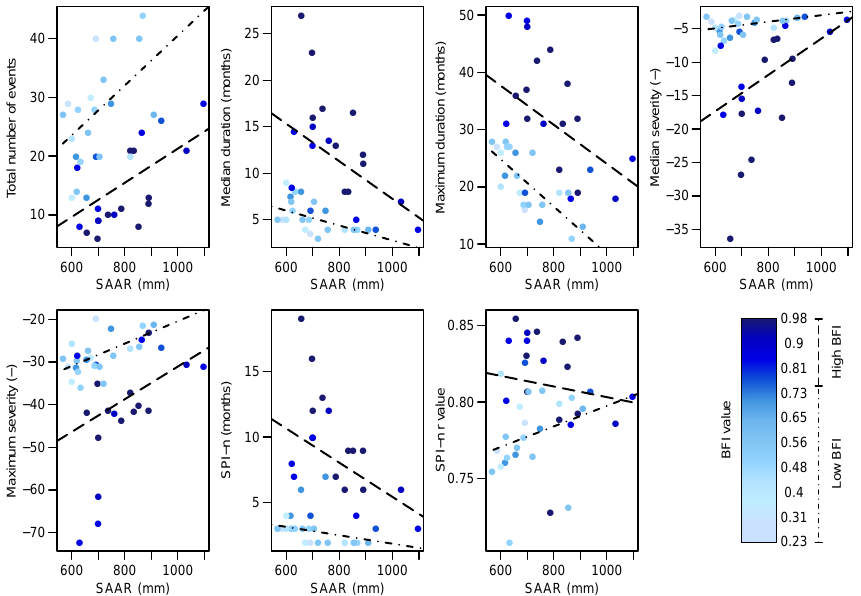
Figure 12. Relationship between hydrological drought characteristics based on SSI-1 using a threshold of − 1 and SAAR for catchments in clusters three and